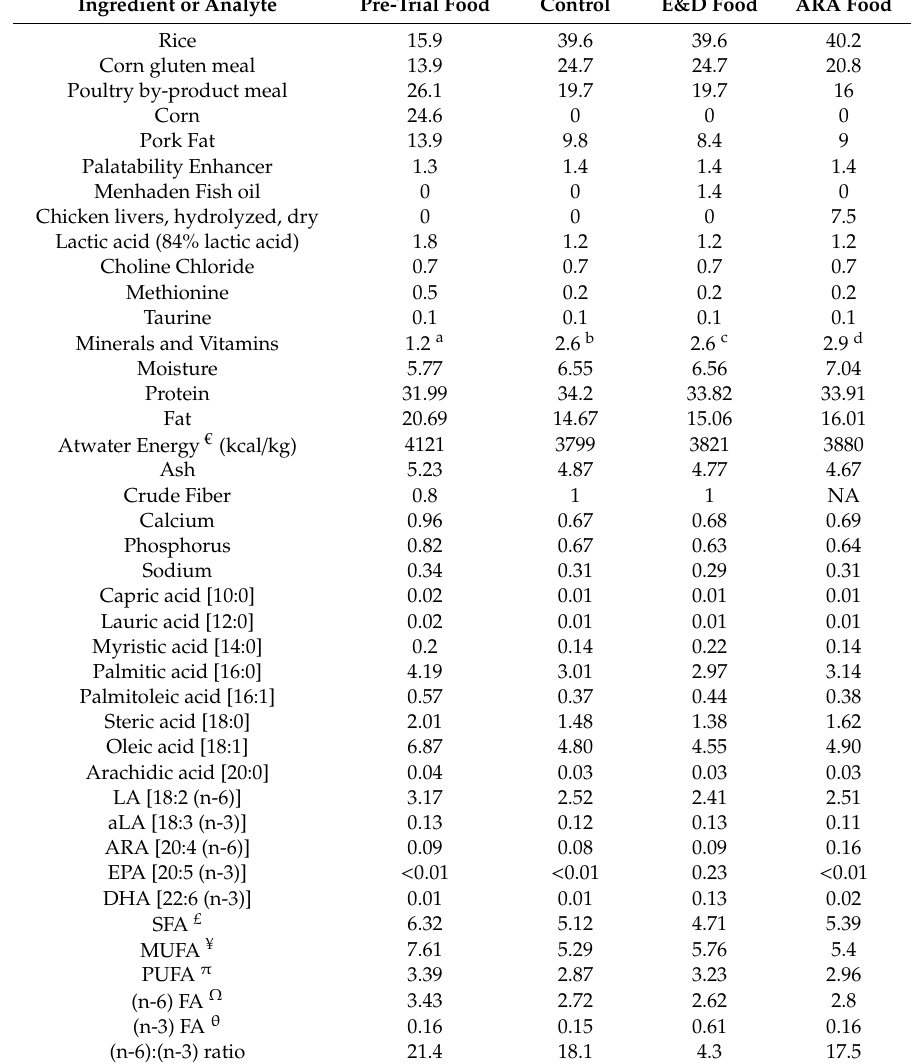
Table 1. Food composition and ingredient make up of pre-trial and test foods (grams / 100 g as mixed or as fed, unless otherwise